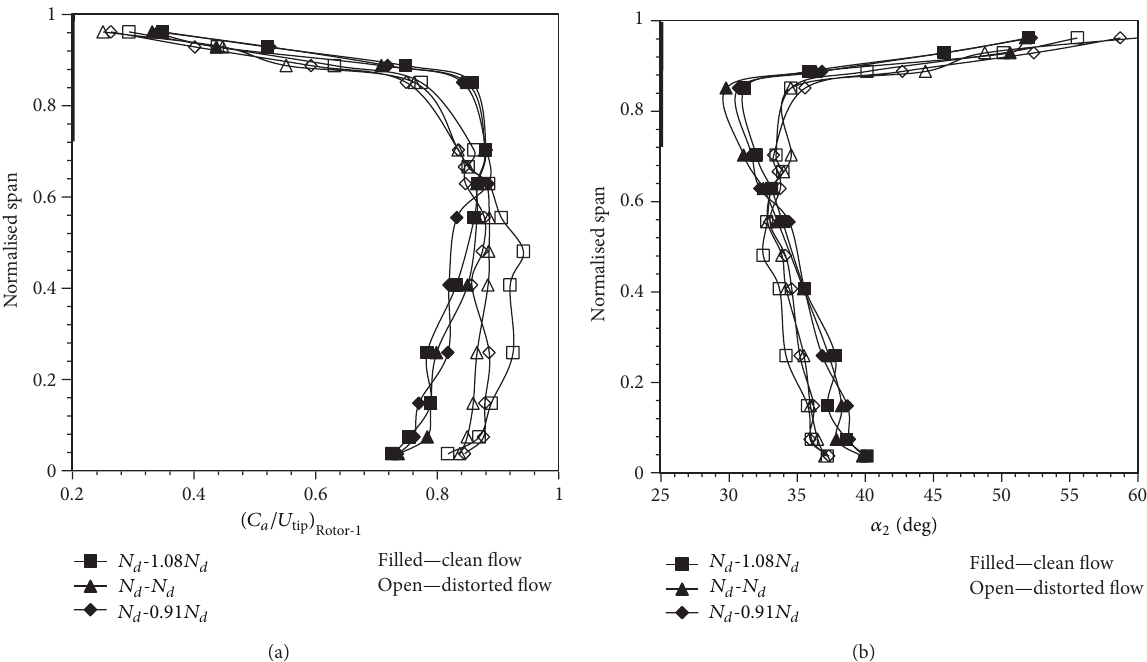
Figure 13: Spanwise variation of (a) axial velocity ratio and (b) flow angle at exit of